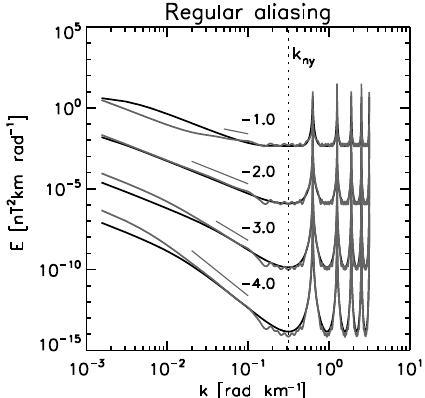
Figure 5. Minimum variance spectra with aliasing for regular spa- tial samplings ( n = 4 in black and n = 20 in gray) with a distance of 10km.